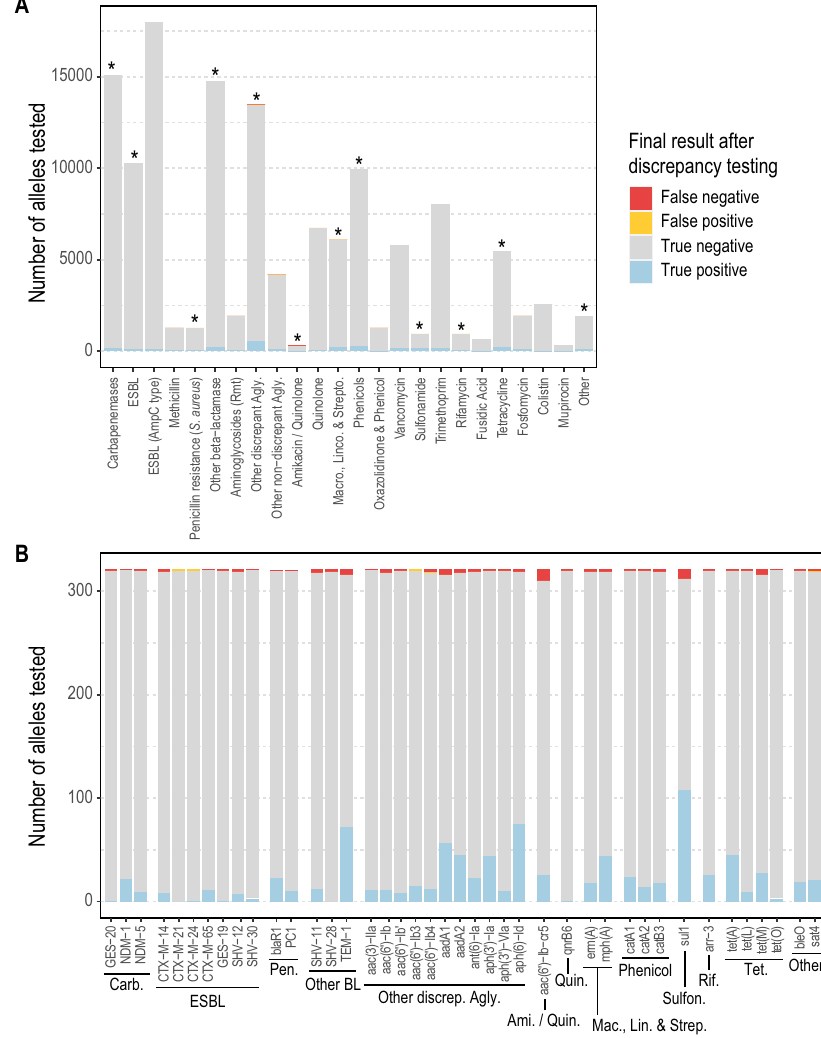
Fig.5|Performanceof abritAMR pipelinecomparedtosyntheticreaddata. This fi gure shows the presence or absence of 415 AMR genes across 321 genomes identi fi edby abritAMR (performedonassembledsyntheticreaddata)comparedto AMRFinderPlus on complete genome sequences ( ‘ gold standard ’ ). True positive, detected by AMRFinderPlus and abritAMR ; true negative, not detected by either AMRFinderPlus or abritAMR; false positive, detected by abritAMR but not by AMR- FinderPlus ; false negative, detected by AMRFinderPlus but not by abritAMR . Panel A , abritAMR results by enhanced subclasses (further grouped to simplify visuali- sation);asterisksrepresentclasseswithanydiscrepantresult(falsepositiveorfalse negative),andareexaminedinmoredetailinPanel B .Panel B showsadetailedview